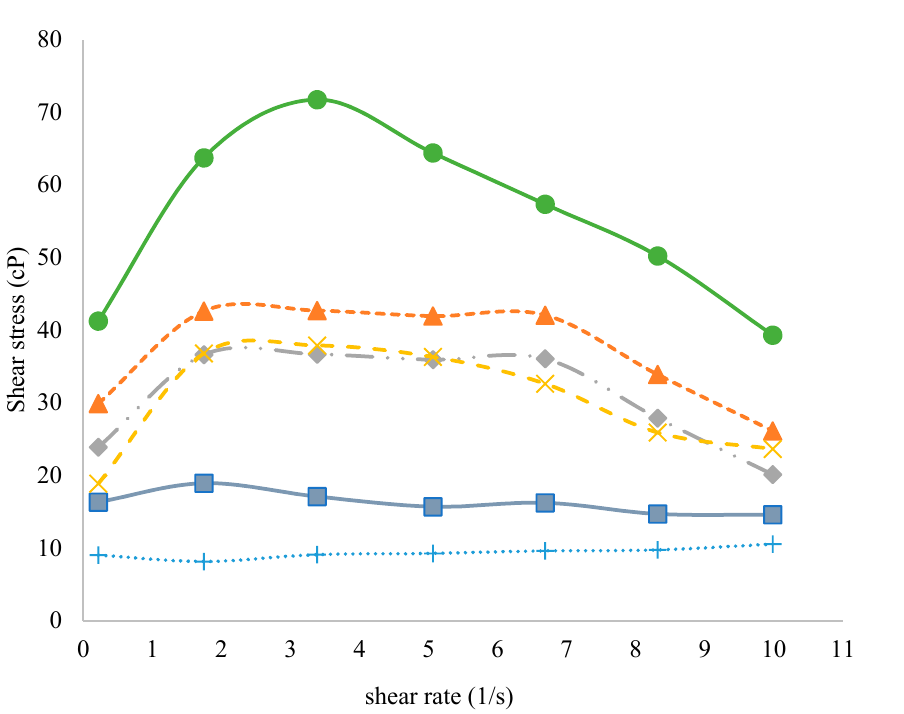
Figure 3. The rheological characteristics of yogurt samples. FFY ( ● ) = full-fat yogurt produced from whole milk powder (WMP); NFY ( ■ ) = non-fat yogurt produced from skim milk powder (SMP); NFYWPI-3 ( ▲ ) = SMP was replaced by 3% WPI; NFYWP-5 ( ♦ ) = SMP was replaced by 5% WPI; NFYWP-7 (x) = SMP was replaced by 7% WPI; NFYWP-9 (+) = SMP was replaced by 9% WPI.